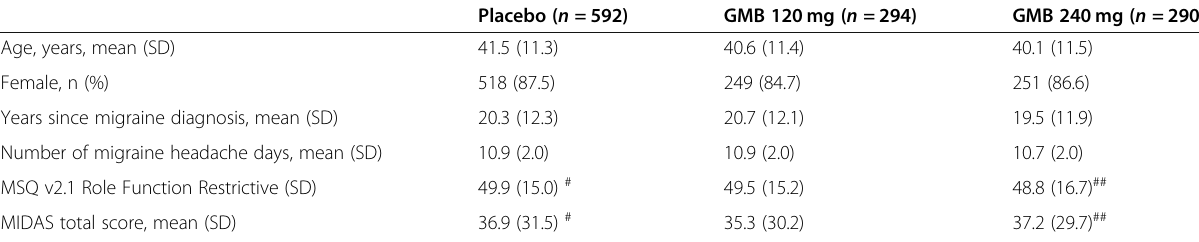
Table 1 Baseline characteristics in patients with HFEM status